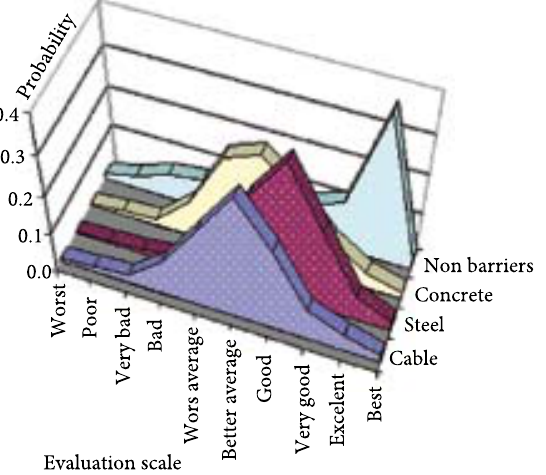
Fig. 8. Graph of a total evaluation for all variants